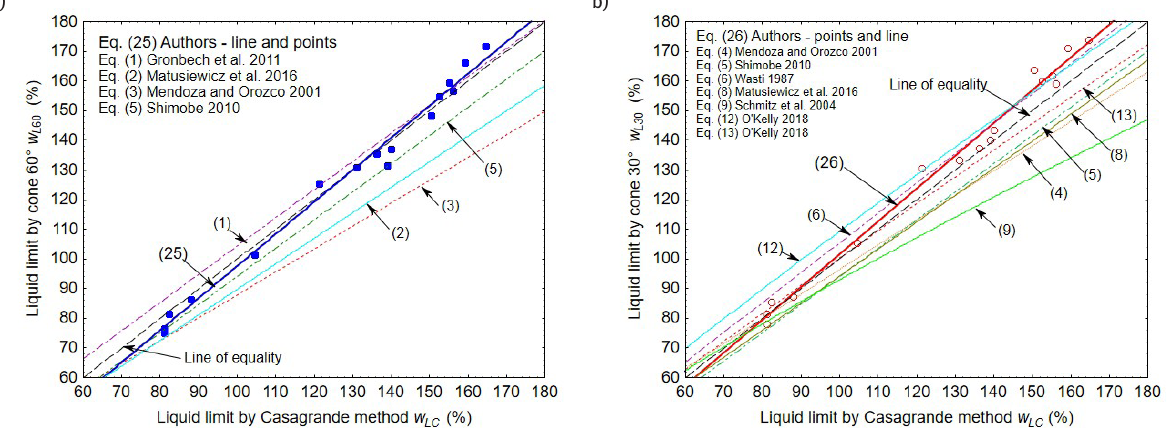
Figure 5: Comparison of relationships obtained by the authors for Eemian gyttja with relationships for cohesive soils taken from the